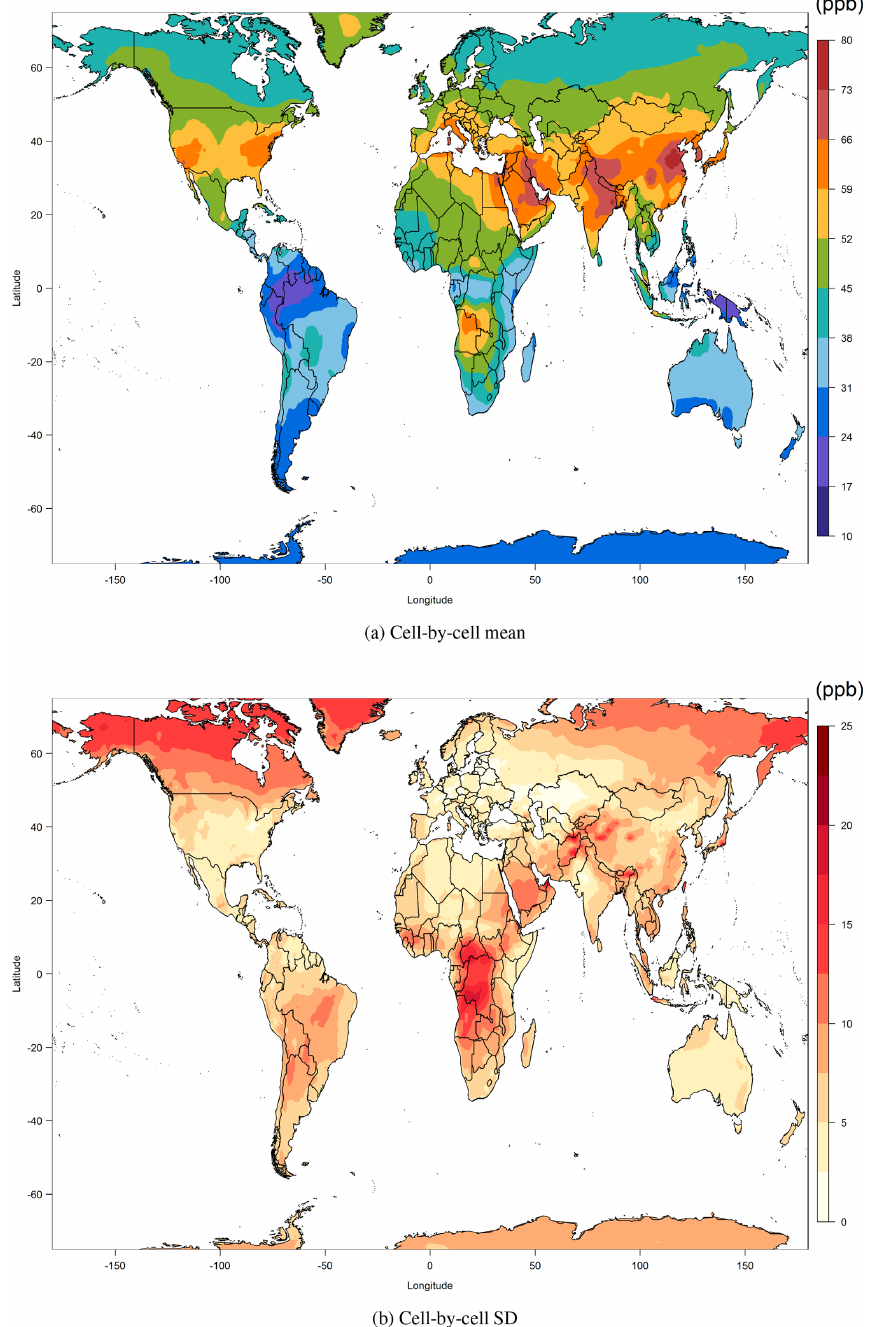
Figure 3. Multi-model mean and standard deviation (SD) in each grid cell from six ensemble members.